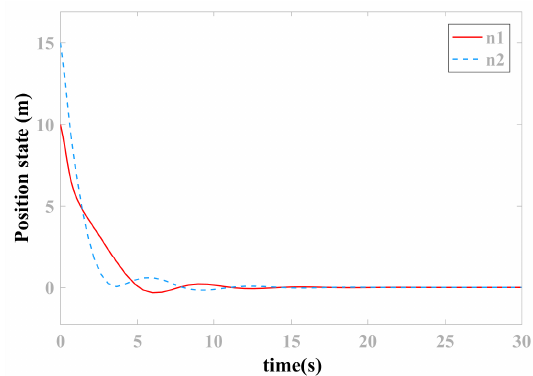
Figure 1. Surge displacement state of two ships ( n 1, n 2 ) .